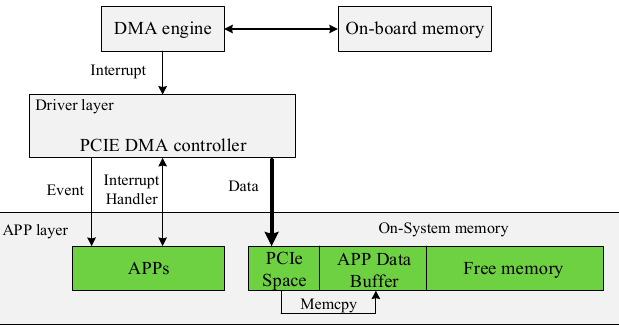
Figure 9. The schematic diagram of DMA transmission architecture.